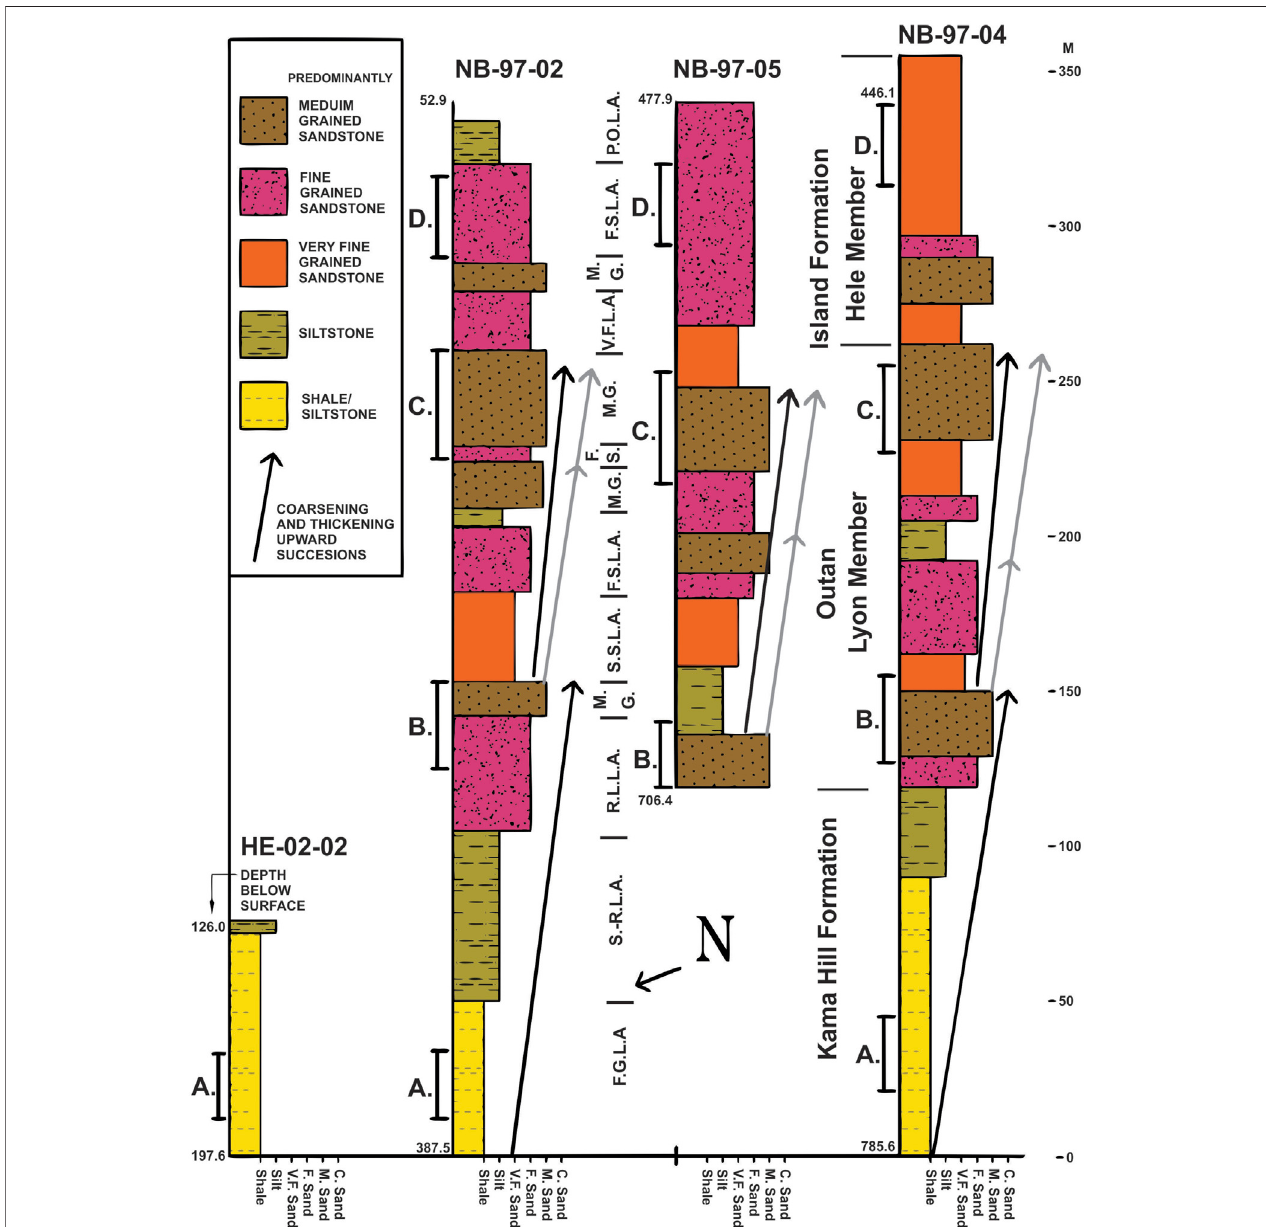
FIGURE2 | Stratigraphy ofthe four drill-holesthat intersected thedeltaic complex. Large-scale coarsening-and thickening-upwardstrendsare marked asare the twosubsidiarycoarseningupwardtrendsinthemiddlecoarseningupwardsuccession.Thelocationoflithofaciesassociationsismarkedby:F.G.L.A.,FineGrainedL.A.; S.-R. L.A., Silt-Rich L.A.; R.L.L.A., Ripple Laminated L.A.; M.G., Medium Grained L.A.; S.S.L.A., Silty Sandstone L.A.; F.S.L.A., Fine-Grained Sandstone L.A.; V.F.L.A., Very Fine-Grained Sandstone L.A.; and P.O.L.A., Poorly Organized L.A. A, B, C and D with brackets refers to more detailed sections present in Figures 3 , 6 , 8 , 9